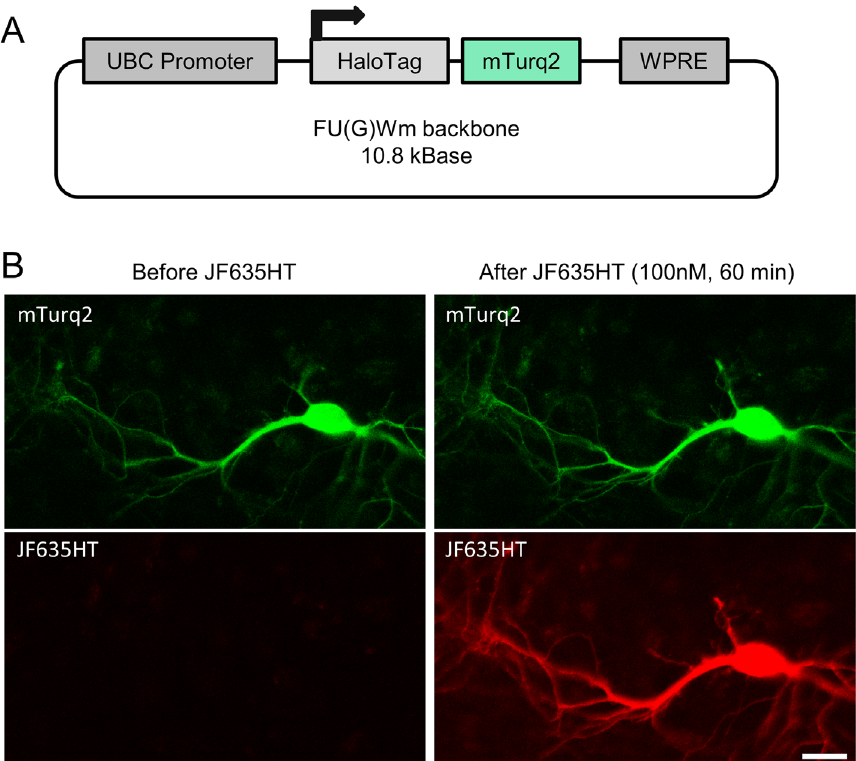
Figure 1. A fusion protein for studying HaloTag labeling and blocker efficacy. ( A ) A lentivirus-based construct for expressing a HaloTag- mTurquoise2 fusion protein in living cells. UBC = Homo sapiens ubiquitin C; WPRE = woodchuck hepatitis virus posttranscriptional regulatory element. ( B ) A cortical neuron in primary culture (17 days in culture) expressing the HaloTag-mTurq2 fusion protein, before (left) and after (right) labeling with JF635HT ligand (100nM, 1 hour). Bar,